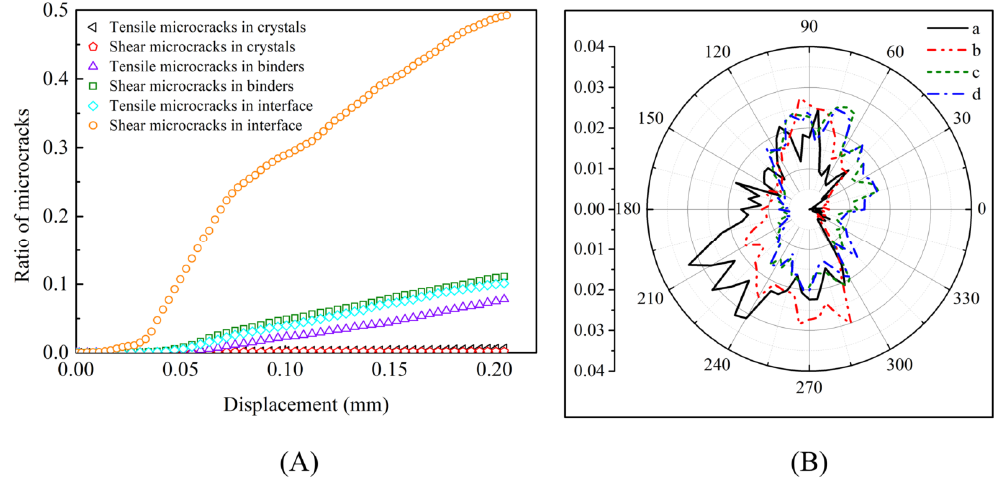
Figure 9. Propagation of microcracks in a realistic short rod particle: ( A ) ratio of the number of different types of microcracks to the number of corresponding bonds; ( B ) normalized polar distribution of the total microcracks evolved on the XY plane: a, b, c, d correspond to four states in Figure 8, respectively.